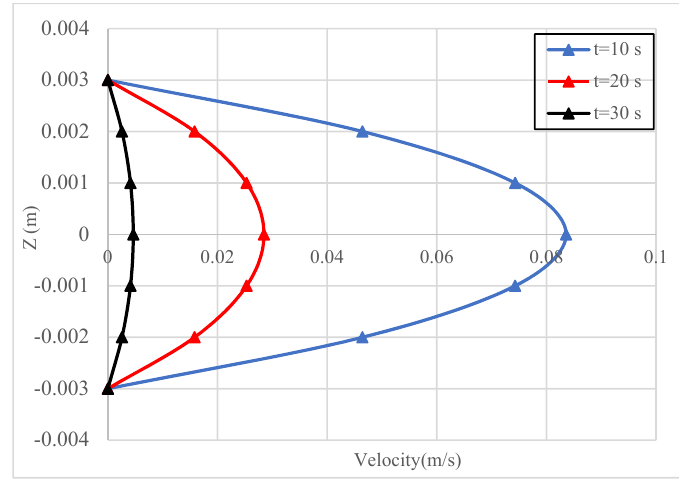
Figure 17. Variation curve of slurry velocity with radial distance at different time.